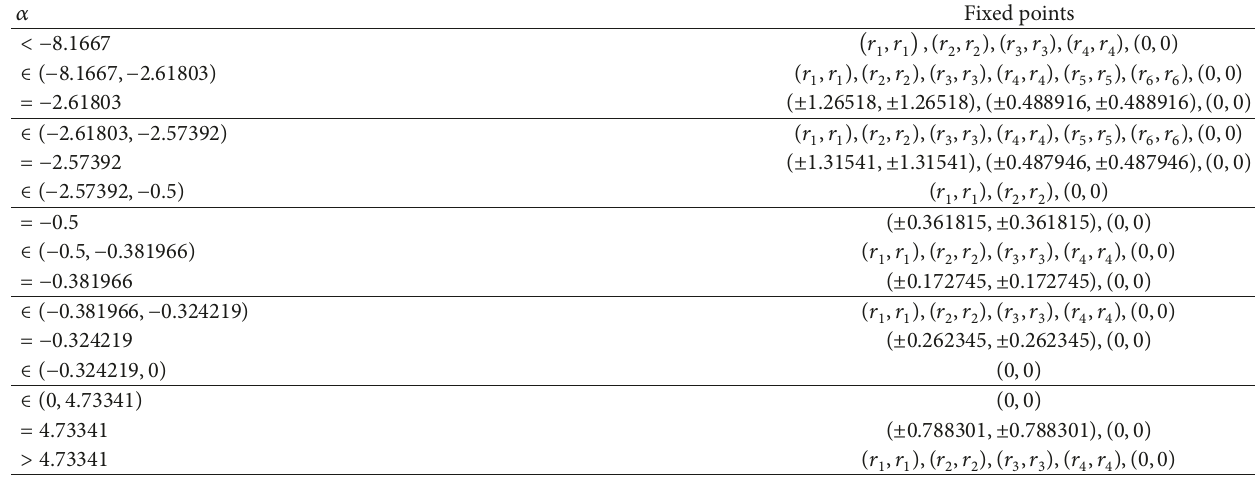
Table 1: Fixed points depending on 𝛼 .